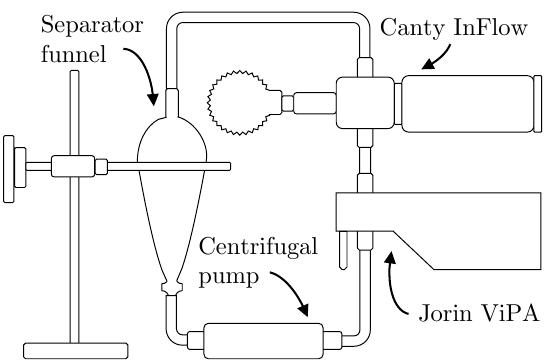
Figure 1. A recirculating test setup for measuring known particle sizes to calibrate both online microscopes.